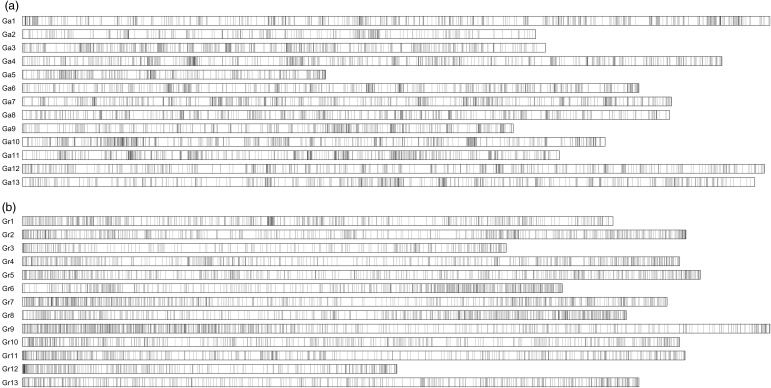
The distribution of the 14,103 contigs on the A2 and D5 genomes. (a) The distribution of contigs on the A2 genome; (b) the distribution of contigs on the D5 genome.